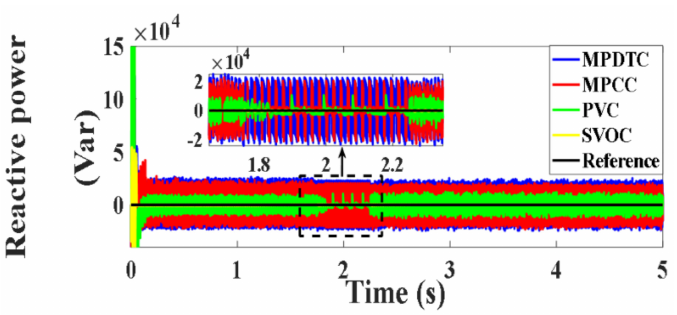
Figure 187. Comparison between reactive powers of four techniques